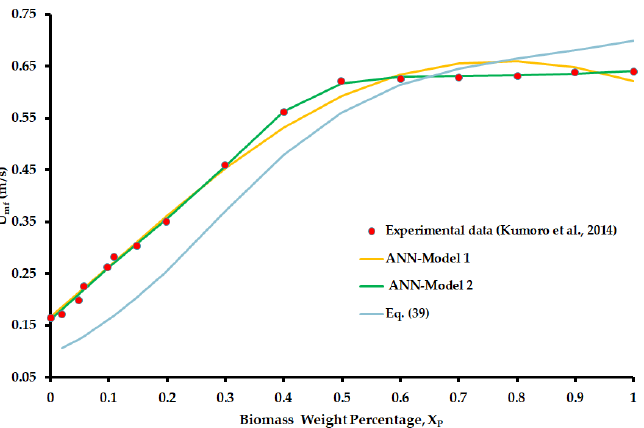
Figure 4. Prediction vs. experimental values of U mf for mixtures of sand-rice husk particles. Experi- mental data extracted from [32].